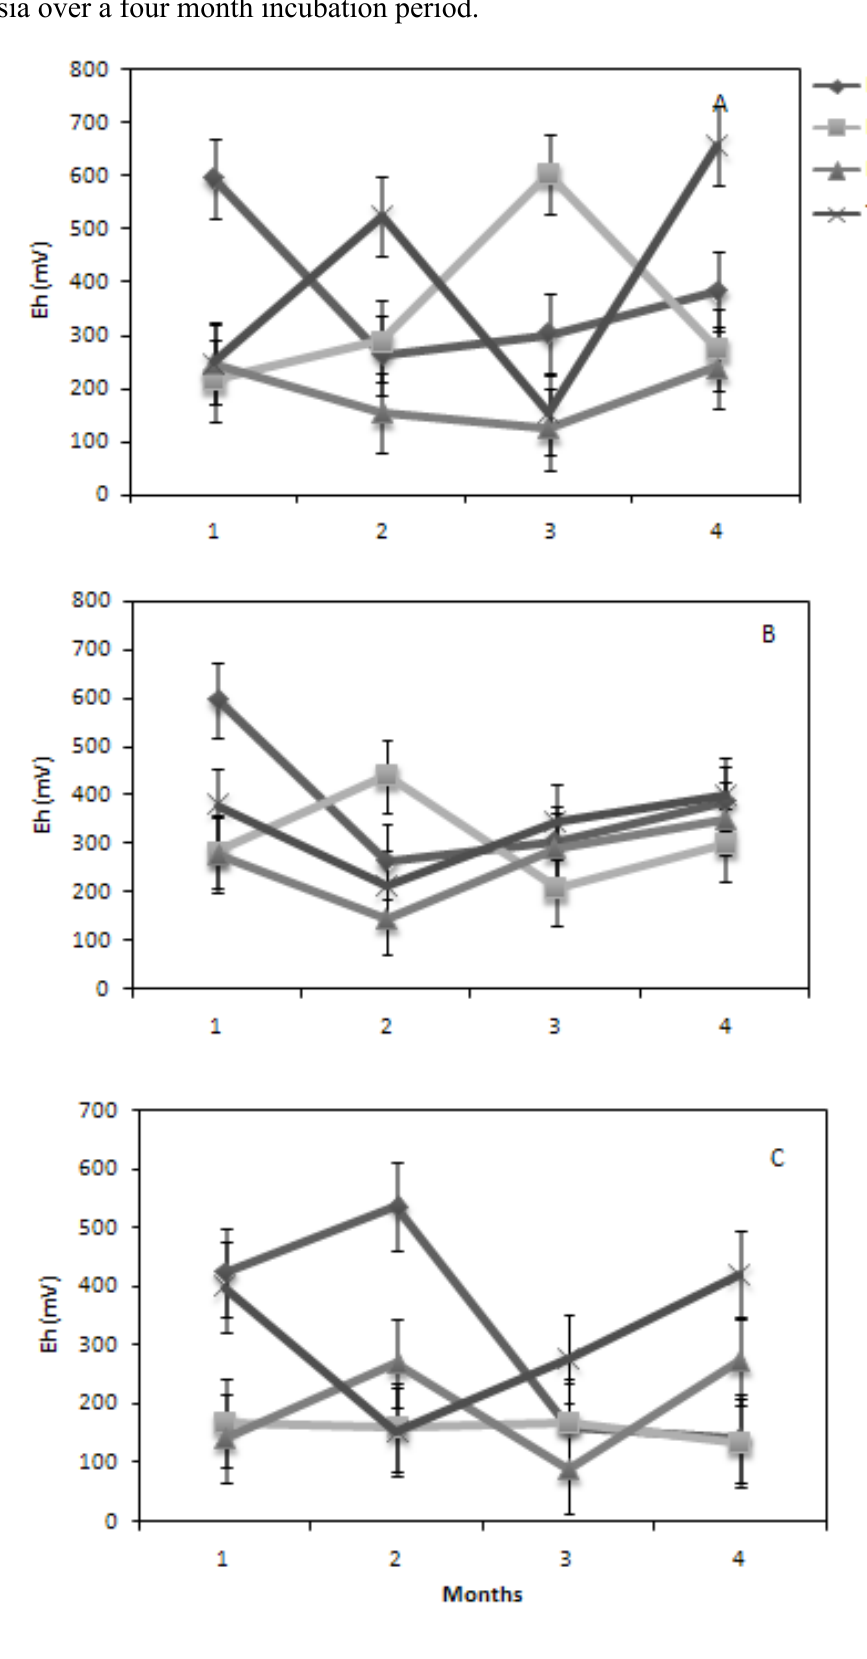
Figure 5. The effects of soils; Piarco (P), Princes Town (PT), River Estate (RE) and Talparo (T) on root zone E for ( A ) Bermuda, ( B ) Savannah and h ( C ) Zoysia over a four month incubation